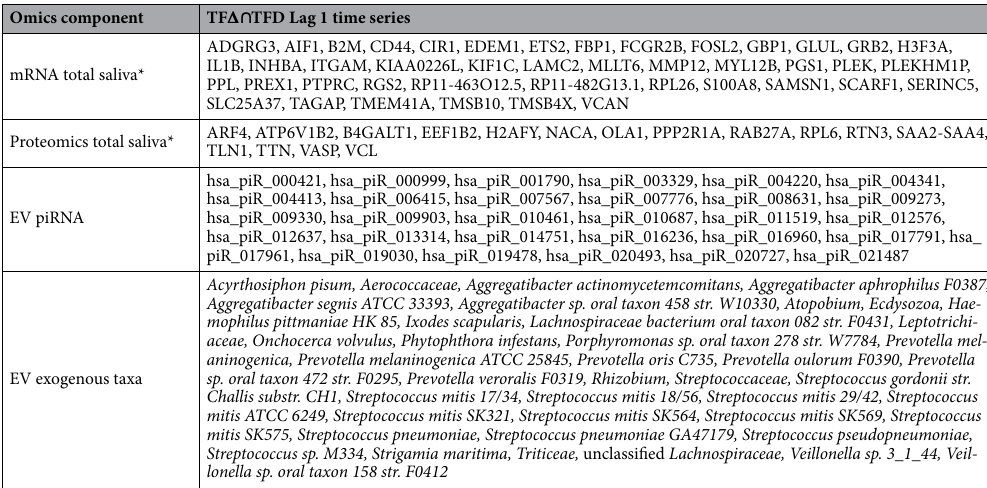
Table 4. Overlaps of responding components between time frames TF (cid:31) and TFD. * Official Gene Names: ADGRG3 adhesion G protein-coupled receptor G3, AIF1 allograft inflammatory factor 1, ARF4 ADP ribosylation factor 4, ATP6V1B2 ATPase H+ transporting V1 subunit B2, B2M beta-2-microglobulin, B4GALT1 beta-1,4-galactosyltransferase 1, CD44 CD44 molecule, CIR1 corepressor interacting with RBPJ, 1, EDEM1 ER degradation enhancing alpha-mannosidase like protein 1, EEF1B2 eukaryotic translation elongation factor 1 beta 2, ETS2 ETS proto-oncogene 2, transcription factor, FBP1 fructose-bisphosphatase 1, FCGR2B Fc fragment of IgG receptor IIb, FOSL2 FOS like 2, AP-1 transcription factor subunit, GBP1 guanylate binding protein 1, GLUL glutamate-ammonia ligase, GRB2 growth factor receptor bound protein 2, H2AFY H2A histone family member Y, H3F3A H3 histone family member 3A, IL1B interleukin 1 beta, INHBA inhibin beta A subunit, ITGAM integrin subunit alpha M, KIF1C kinesin family member 1C, LAMC2 laminin subunit gamma 2, MLLT6 MLLT6, PHD finger domain containing, MMP12 matrix metallopeptidase 12, MYL12B myosin light chain 12B, NACA nascent polypeptide-associated complex alpha subunit, OLA1 Obg like ATPase 1, PGS1 phosphatidylglycerophosphate synthase 1, PLEK pleckstrin, PLEKHM1P Pleckstrin Homology And RUN Domain Containing M1 Pseudogene 1 2 3 5, PPL periplakin, PPP2R1A protein phosphatase 2 scaffold subunit Aalpha, PREX1 phosphatidylinositol-3,4,5-trisphosphate dependent Rac exchange factor 1, PTPRC protein tyrosine phosphatase, receptor type C, RAB27A RAB27A, member RAS oncogene family, RGS2 regulator of G-protein signaling 2, RP11-463O12.5 to be experimentally confirmed, RP11-482G13.1 novel transcript similar to family member with sequence similarity 157, RPL26 ribosomal protein L26, RPL6 ribosomal protein L6, RTN3 reticulon 3, S100A8 S100 calcium binding protein A8, SAA2–SAA4 SAA2–SAA4 readthrough, SAMSN1 SAM domain, SH3 domain and nuclear localization signals 1, SCARF1 scavenger receptor class F member 1, SERINC5 serine incorporator 5, SLC25A37 solute carrier family 25 member 37, TAGAP T-cell activation RhoGTPase activating protein, TLN1 talin 1, TMEM41A transmembrane protein 41A, TMSB10 thymosin beta 10, TMSB4X thymosin beta 4, X-linked, TTN titin, VASP vasodilator-stimulated phosphoprotein, VCAN versican, VCL